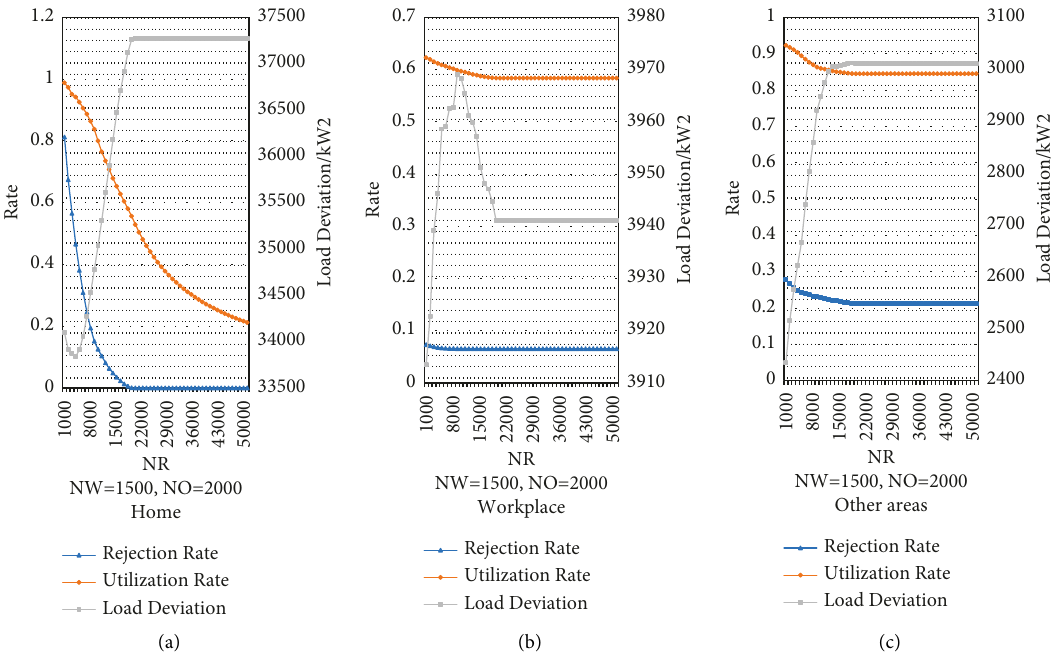
Figure 5: Influence of the number of charging piles in residential areas (NR) on operational efficiency. (a) Home. (b) Workplace. (c) Other